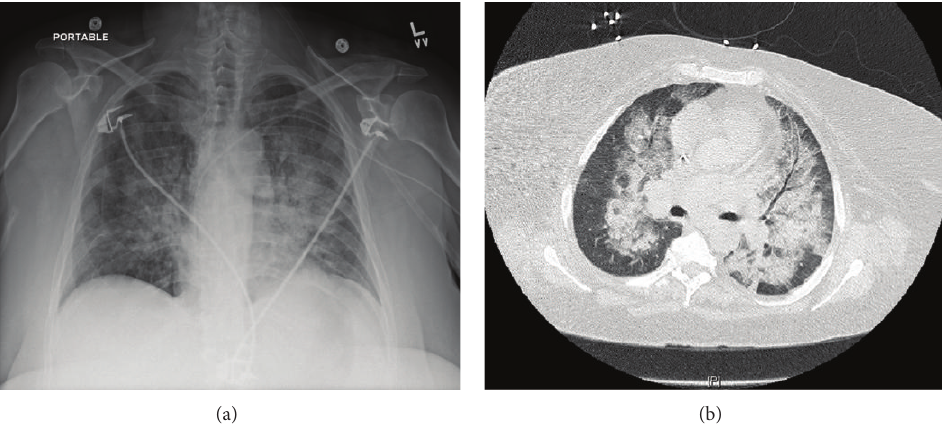
Figure 2: Chest X-ray (a) and computed tomography (b) demonstrating bilateral pulmonary infiltrates. appendicitis with retroperitoneal and mesenteric lymph